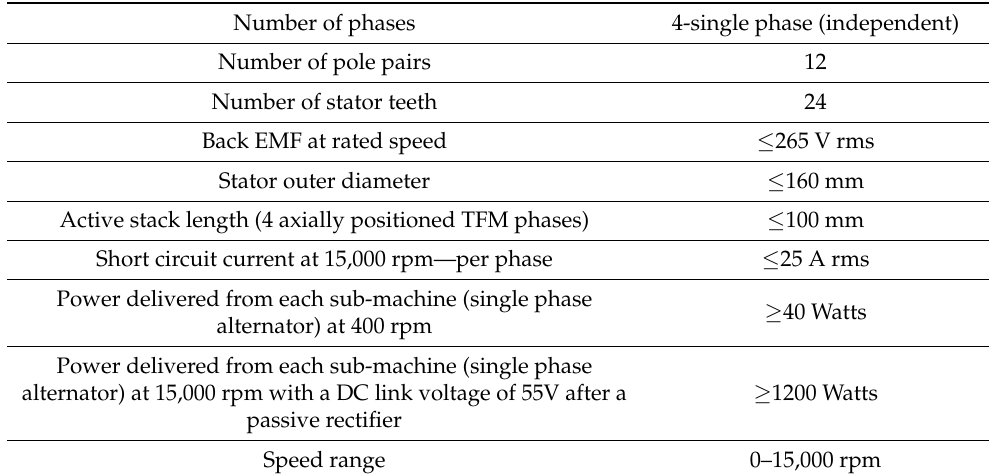
Table 1. Key properties of the proposed transverse flux machine.